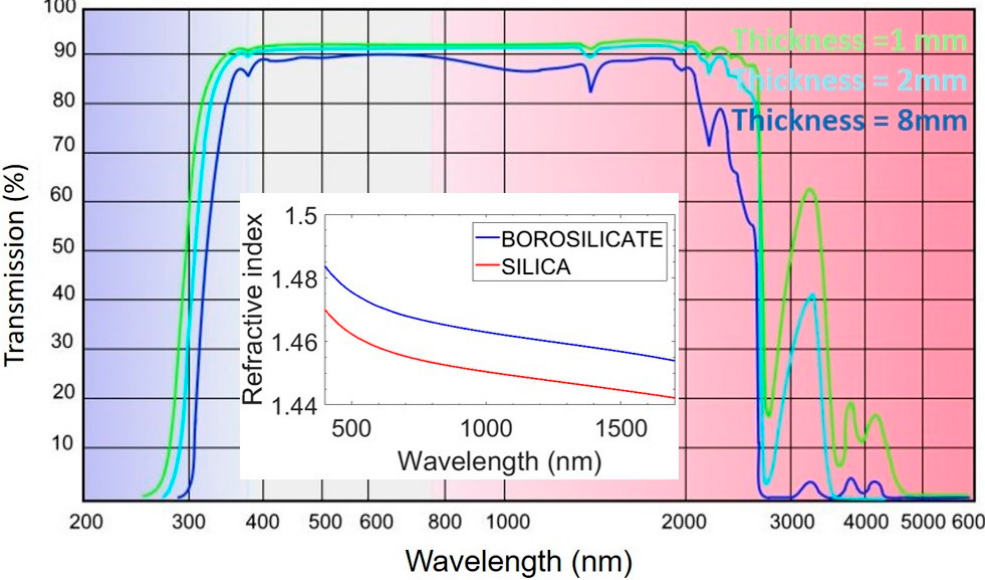
Figure 1. Transmission of DURAN 8330 glass for different glass thicknesses. Inset: comparison between refractive index of borosilicate and pure silica glass in the visible and near-infrared spectral range.